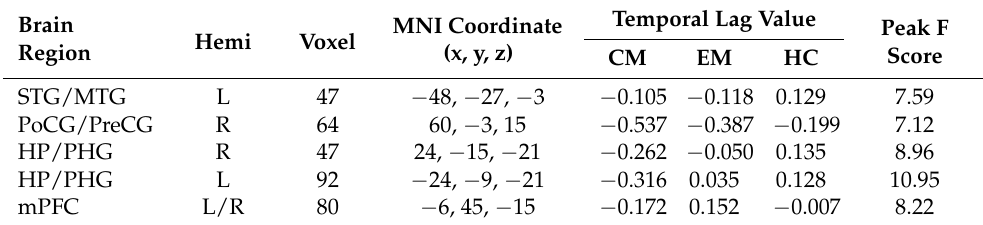
Hemi, hemisphere; MNI, Montreal Neurological Institute; L, left; R, right; CM, the chronic migraine group; EM, the episodic migraine group; HC, the healthy control group; STG, superior temporal gyrus; MTG, middle temporal gyrus; PoCG, postcentral gyrus; PreCG, precentral gyrus; HP, hippocampus; PHG, parahippocampal gyrus; mPFC, medial prefrontal